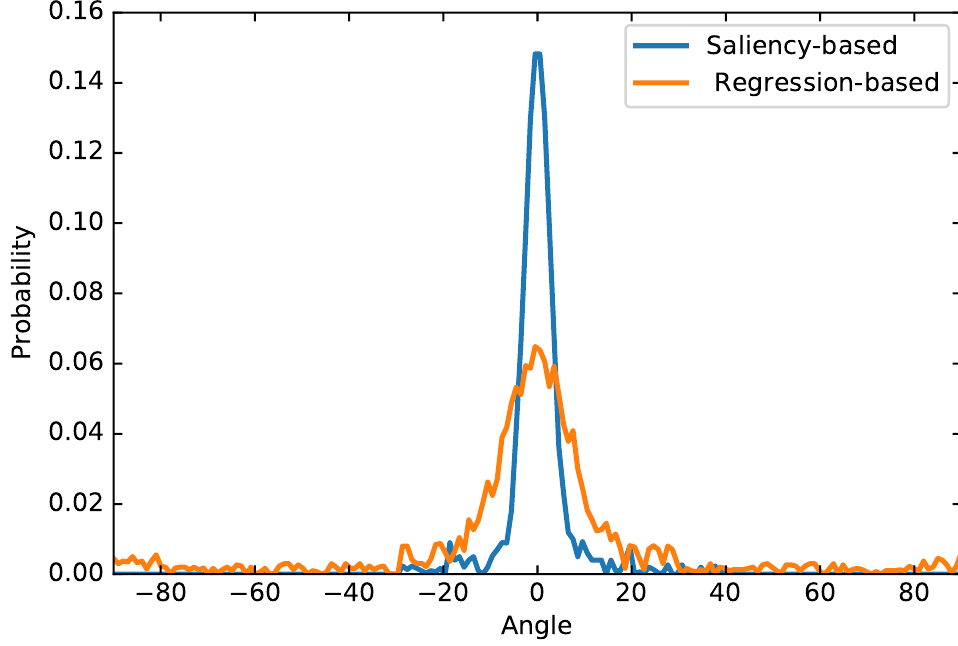
Figure 4. In the UCAS-AOD dataset, the errors of the angles are statistically obtained in the figure for the oriented bboxes generated based on regression and the oriented bboxes generated based on significance,